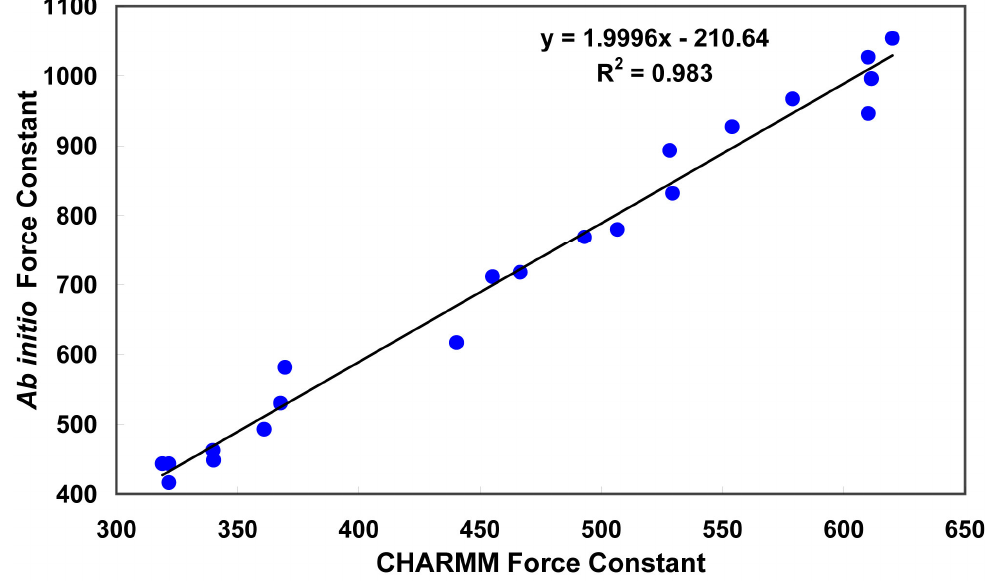
Figure 3 . Correlation between CHARMM versus Ab Initio force constant ( k ¶¶¶ ),...,( 12 = i, j = 1,…, N, where E ( c , N = 3M - 6 independent internal coordinates, M being the number of atoms of the QM system. In the present case, M = 30. The terms used in the CHARMM force field correspond to the diagonal elements, k divided by 2 (the factor 0.5 of the Taylor expansion for the energy is included in the force i,j